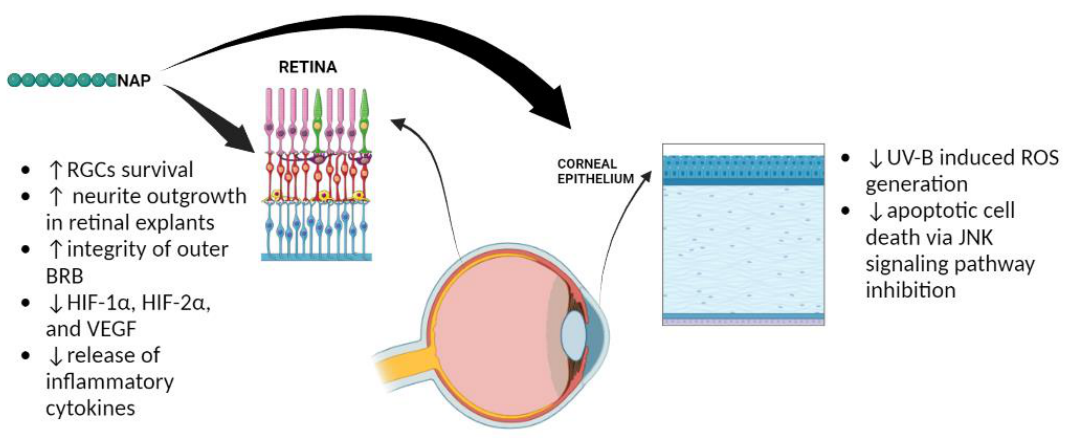
Figure 3. Protective effects played by NAP in the eye. The ↑ and ↓ refer to increase and decrease, respectively.